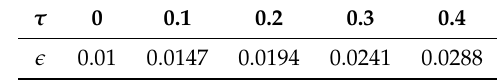
Table 1. The total excess noise (cid:101) of the system under different crosstalk levels τ